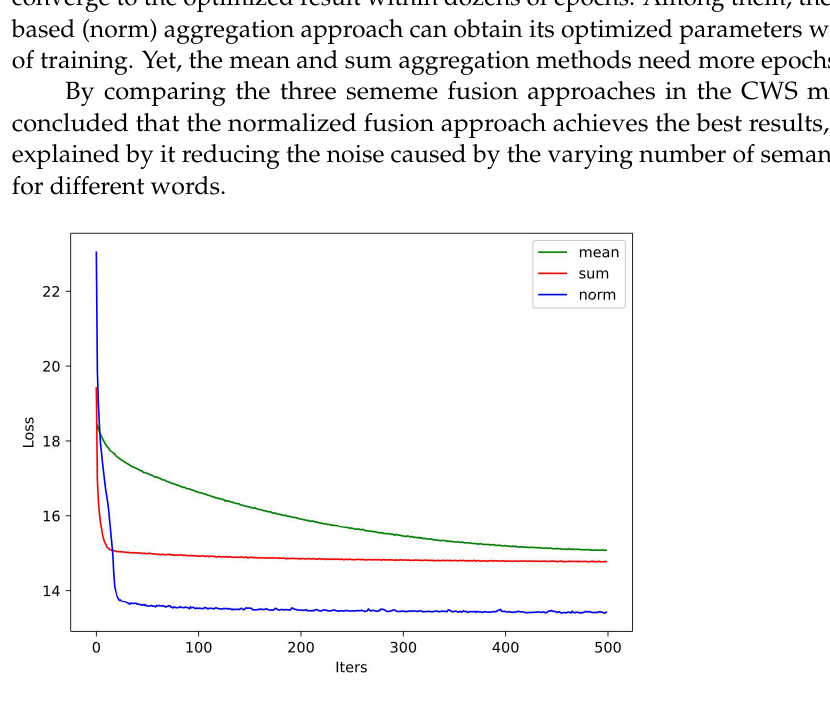
Figure 4. Loss curves of the three sememe aggregation methods during the training